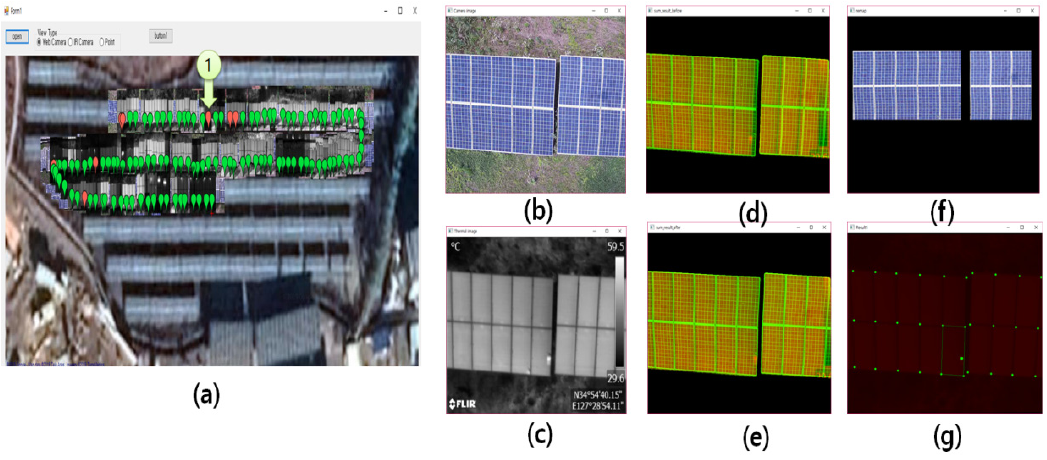
Figure 16. Abnormal module detection system: ( a ) main result screen; ( b ) visible image; ( c ) thermal image; ( d ) merge image before registration; ( e ) merge image after registration; ( f ) normalized image; ( g ) abnormal region derivation result.